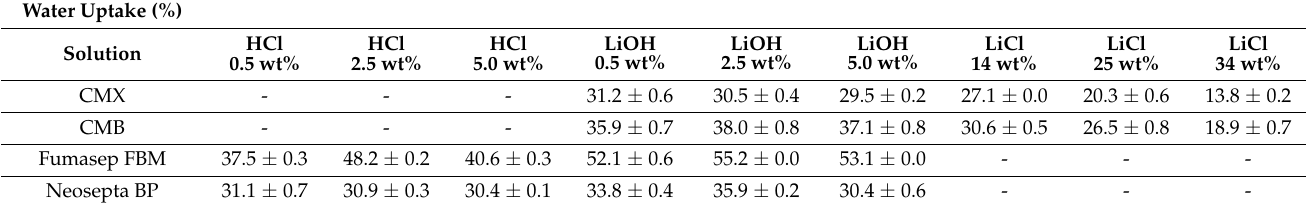
Table 6. Water uptake measured in cation-exchange and bipolar